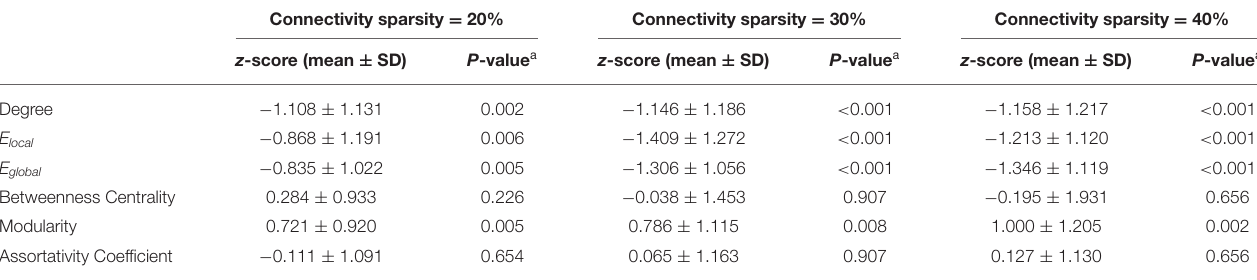
TABLE 1 | Mean z -scores of network parameters in the contralateral hemispheres.